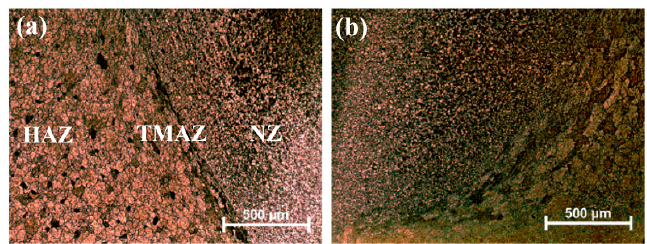
Figure 9. Microstructure of welded sample around nugget zone at advancing side ( a ) and retreating side ( b ) for the RAFSW joint aged artificially at 160 °C for 16 h.